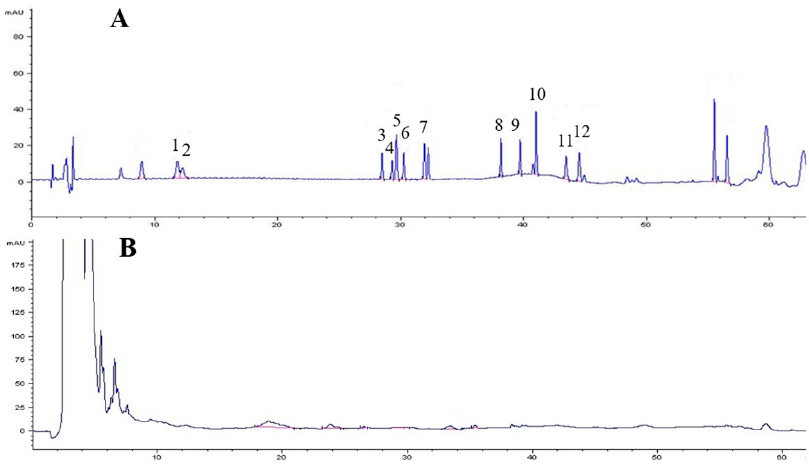
Figure 1. The HPLC profile of ginsenoside standards ( A ); and the fermentation broth of strain LB 5-3 ( B ). The peaks 1–12 represents ginsenosides Rg1, Re, Rh1, Rb1, F1, Rb2, Rd, F2, Rg3, CK, Rh2, and PPD respectively.